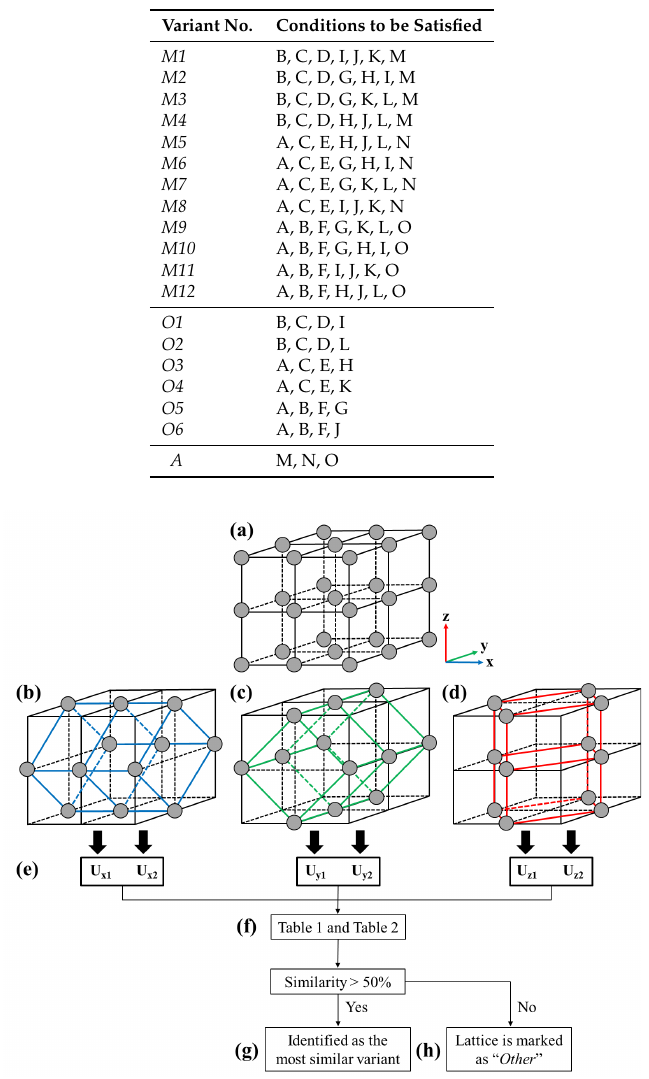
Table 2. The satisfied conditions for the austenite ( A ) phase and each variant of the orthorhombic ( O ) and monoclinic ( M ) phases.